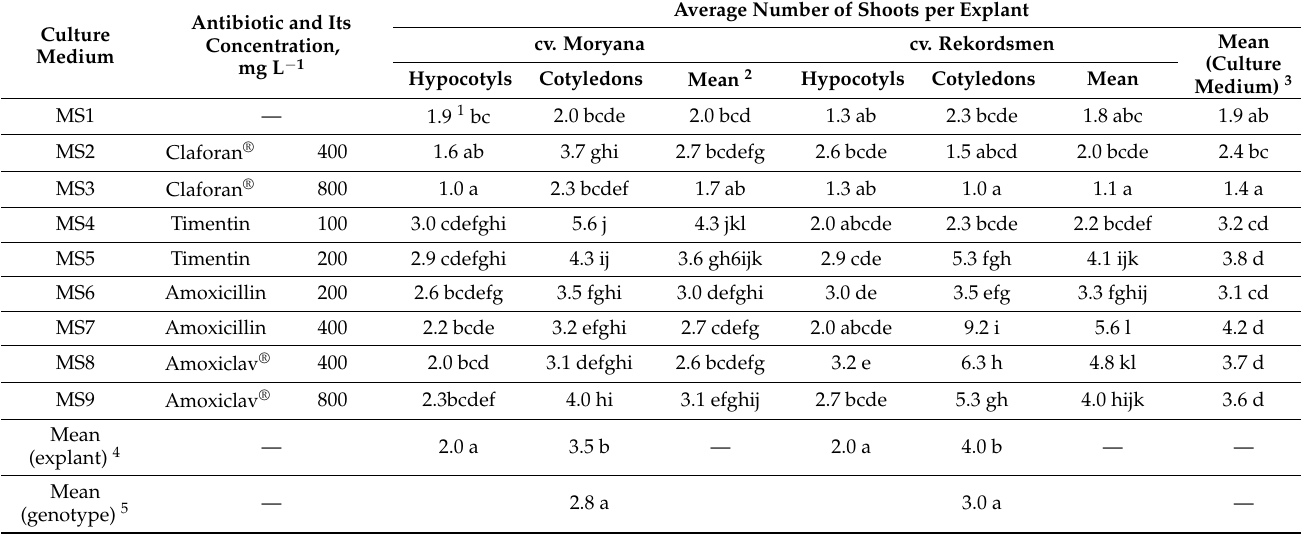
Table 3. The effects of genotype, explant type, and culture medium components on the average number of tomato shoots produced per explant in